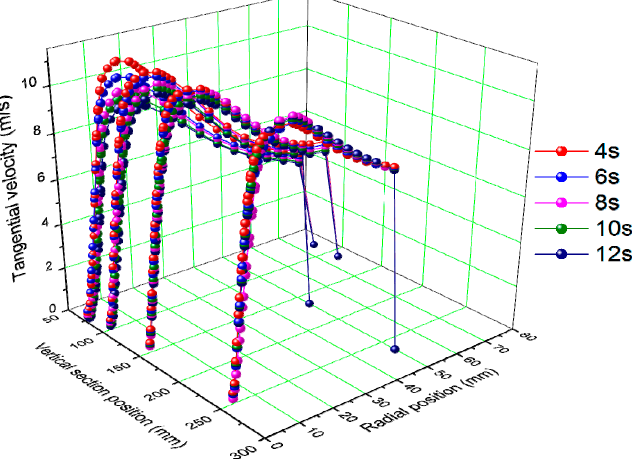
Figure 14. Distribution curve of tangential velocity.